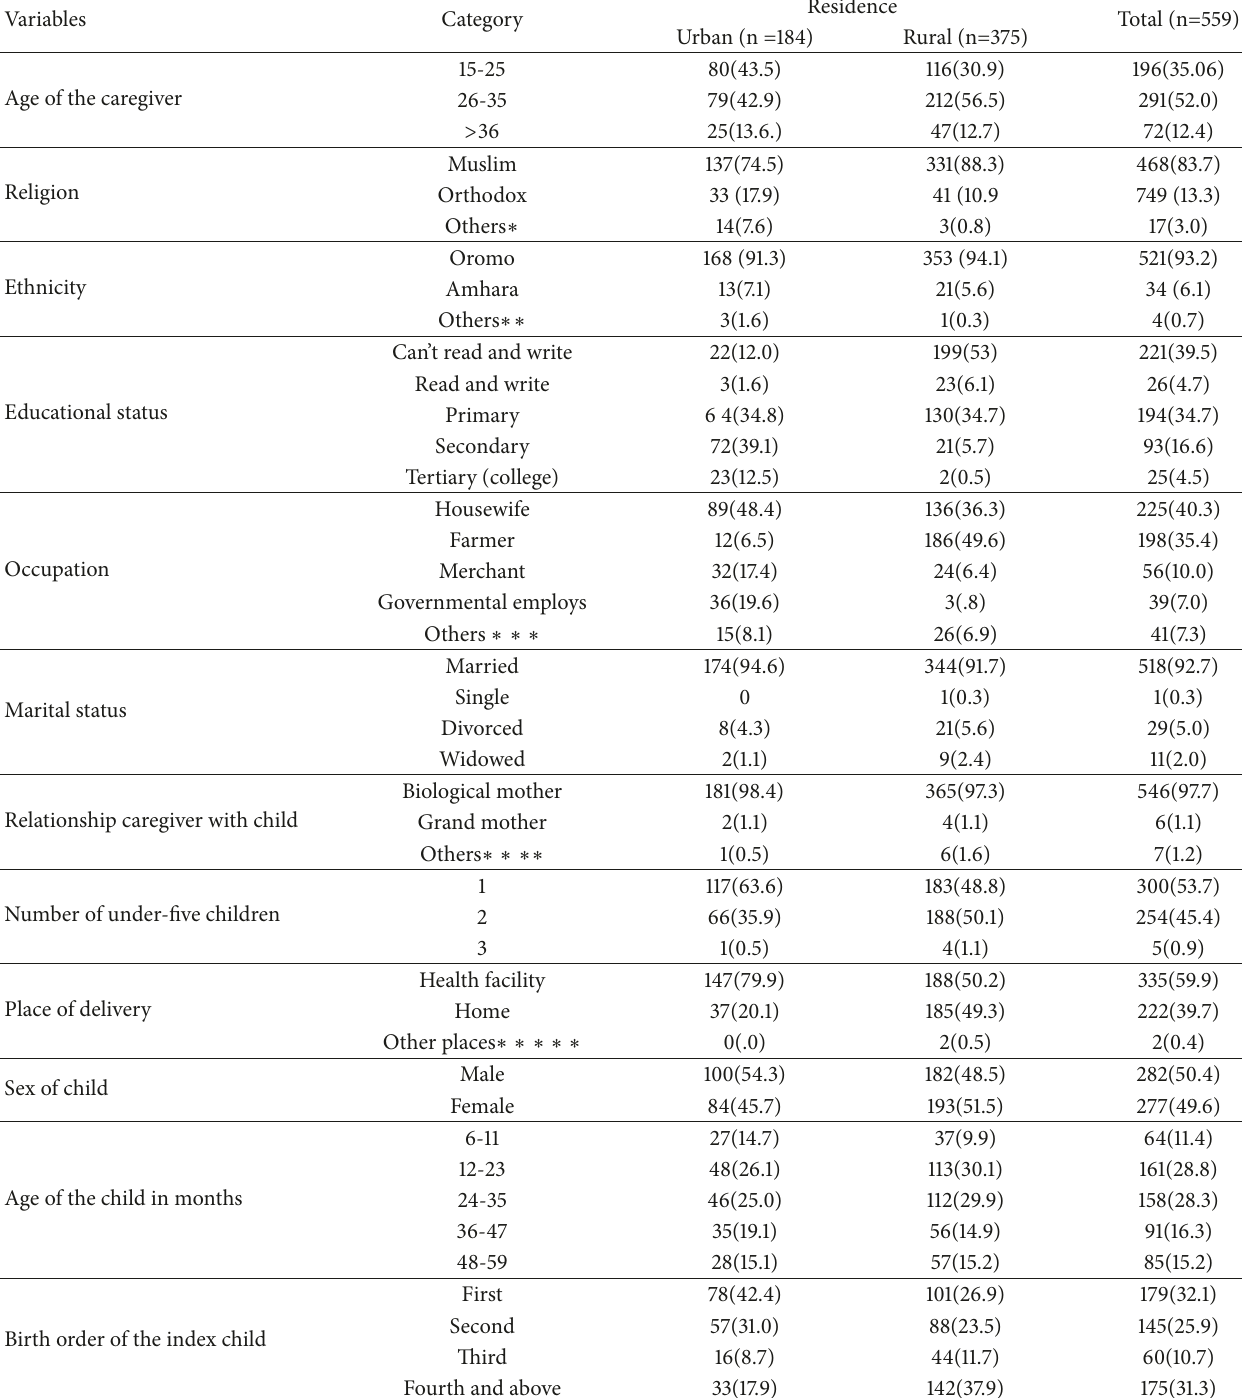
Table 1: Socio-demographic characteristics of caregivers of under-five children’s in urban and rural resident of Doba woreda, Ethiopia,